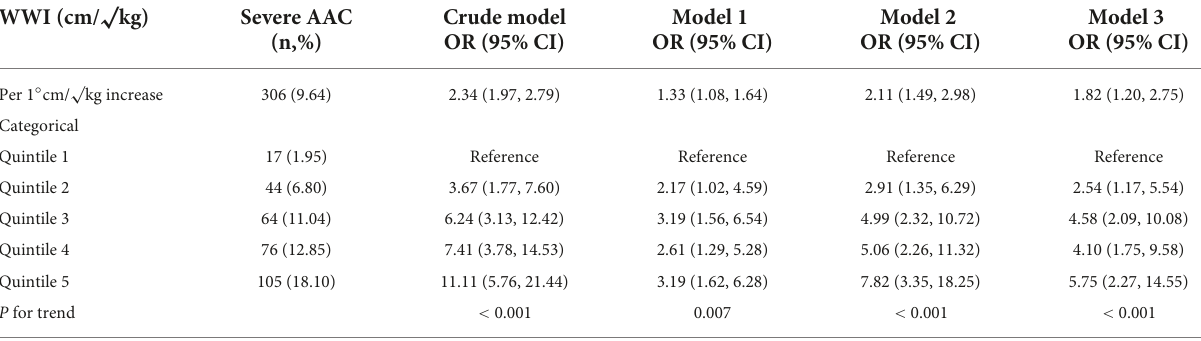
TABLE 3 Association between weight-adjusted-waist index (WWI) level and severe abdominal aortic calcification (AAC) in United States adults from national health and nutrition examination survey (NHANES) 2013–2014. √ WWI (cm/ kg)